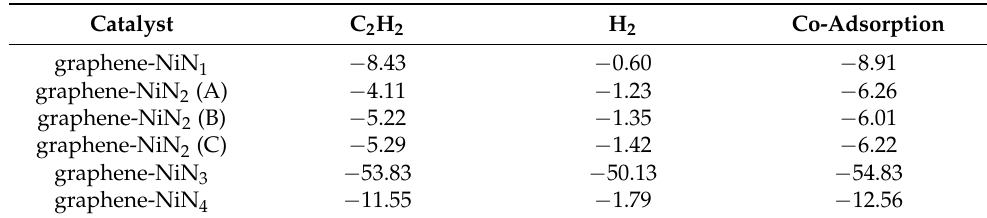
Figure 3. The DOS of graphene-NiN 1 , graphene-NiN 2 (A), graphene-NiN 2 (B), graphene-NiN 2 (C), graphene-NiN 3 and graphene-NiN 4 , and corresponding HOMO and LUMO. Table 2. Single and co-adsorption energies of C 2 H 2 and H 2 adsorbed on graphene-NiN x (x = 1, 2, 3, 4) catalysts (energy unit: